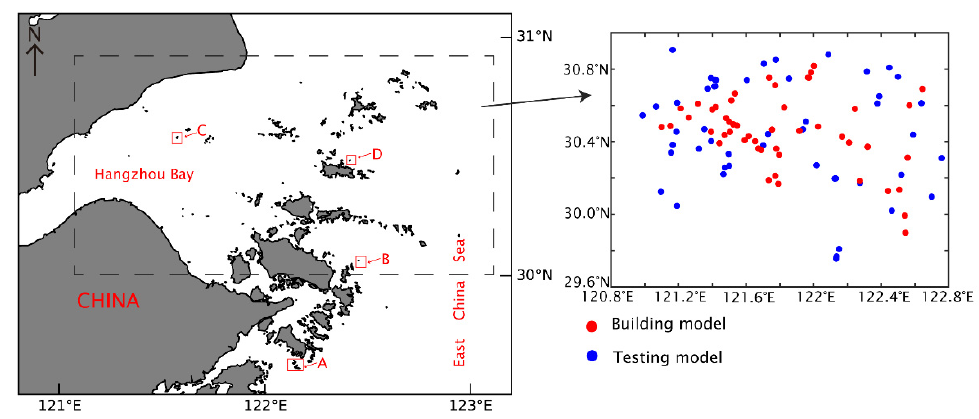
Figure 1. Location of Hangzhou Bay and Zhoushan Islands (The black dotted box: the Zhoushan Islands; the small red boxes A, B, C, D; the places where the vortex streets appear).